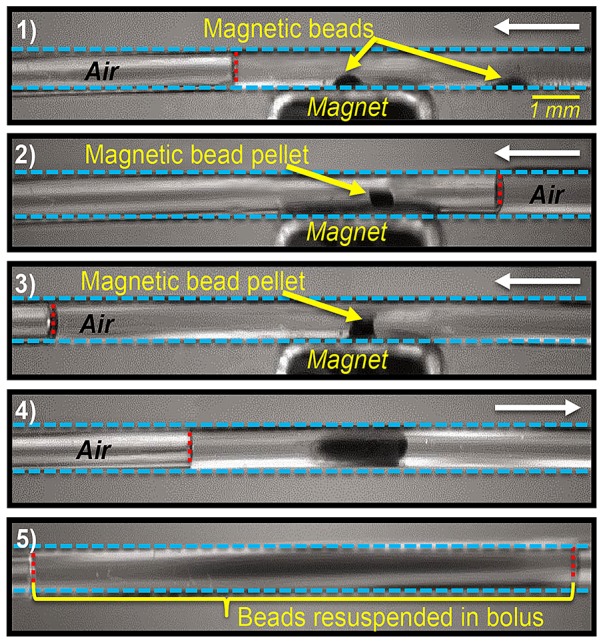
Modular format for implementing magnetic bead-based steps.Series of images from a movie (side-view) depicting key magnetic bead-based steps in an off-DMF module. Blue- and red-dashed lines show the walls of module and air/bolus interface, respectively. (1, 2) An external magnet immobilizes beads onto the tube surface. (3) Positive pressure-driven flow separates supernatant away from the bead pellet. (4, 5) Removing the magnet and shuttling a bolus of solution over the pellet resuspends immobilized beads. Arrows indicate the direction of bolus movement.